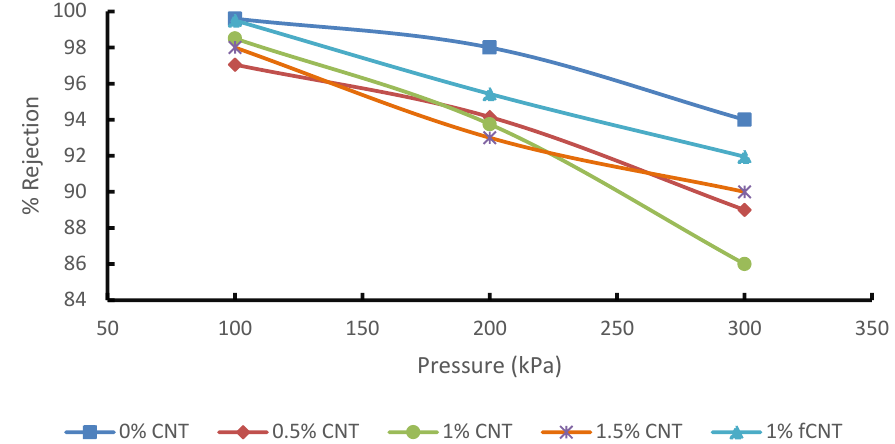
Membranes 2019 , 9 , x FOR PEER REVIEW Figure 7. E ff ect of pressure and CNT concentration on benzene rejection. Figure 7. Effect of pressure and CNT concentration on benzene rejection.